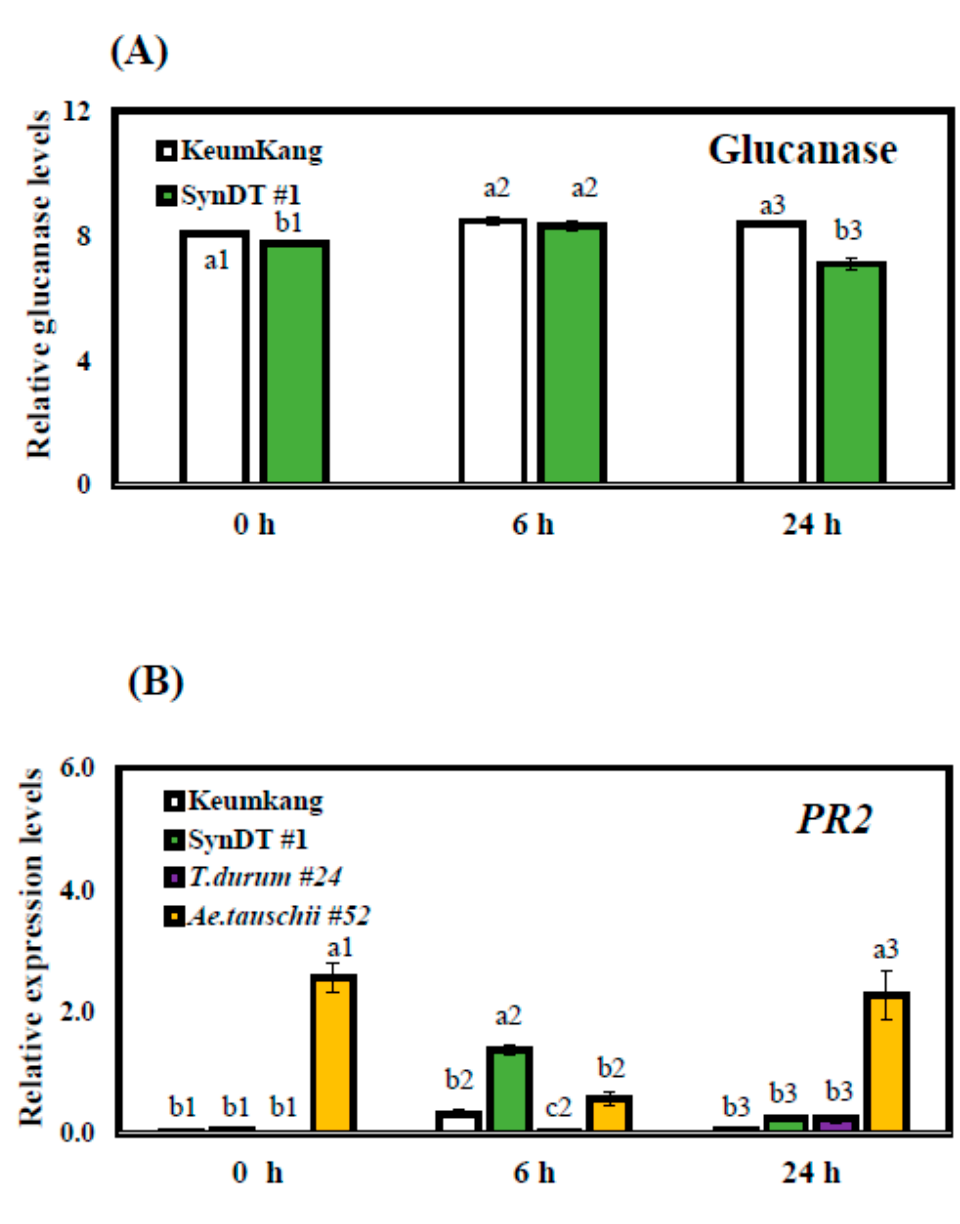
Figure 7. Glucanase levels in response to leaf rust (LR) infection. ( A ) Levels of glucanase in Keumkang and SynDT #1 in response to LR at 0, 6, and 24 hpi. ( B ) Relative expression levels of PR2 in Keumkang, SynDT #1, T. durum #24 , and Ae. tauschii #52 in response to LR at 0, 6, and 24 hpi. Eight-day-old seedlings were exposed to LR. Samples were collected after 0, 6, and 24 hpi for enzymatic assay or to measure transcript levels. The experiments were conducted at least twice to verify that the results were consistent. Standard deviation value was calculated from three replicates in each treatment. One-way ANOVA and Tukey’s test ( α = 0.05) were performed using SAS. Different letters (a, b, or c) indicate significant differences ( p <